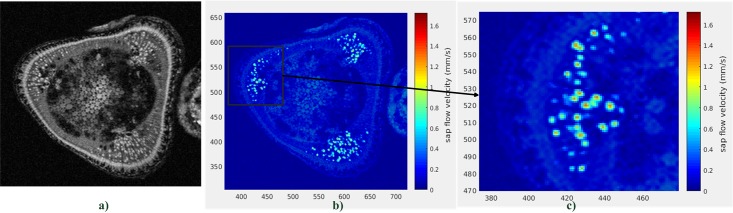
Illustration of xylemian sapflow imaging on tomato stem.a) Anatomical image acquisition (TR = 1.2s, TE = 15ms, FOVREAD = 40mm, FOVPHASE = 40mm, NREAD = NPHASE = 256) b) Superimposition of the anatomical acquisition (background) with the flow acquisition (only the active xylematic tissues appear) c) Zoom on an active xylematic tissue region showing an higher intensity at the center of individual xylematic tissues.